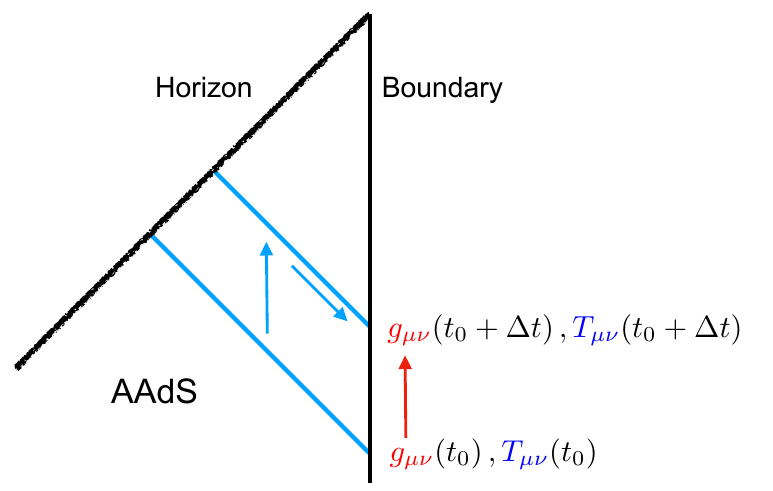
Figure 1 . Penrose diagram of our evolution scheme. The diagonal blue lines are four-dimensional null slices in the bulk. Each point on the vertical black line is a three-dimensional spatial slice of the boundary